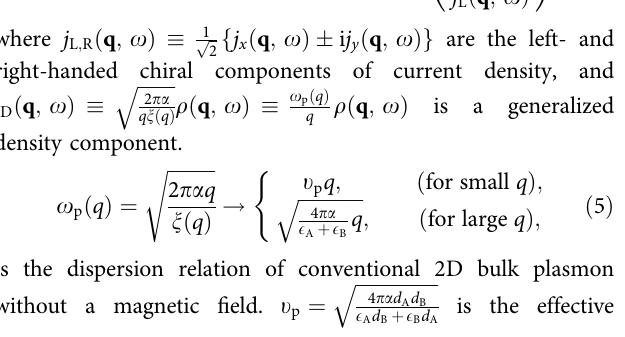
q ffiffiffiffiffiffiffiffiffiffiffiffiffiffiffiffiffi 4 pa d A d B is the E A d B þ E B d A